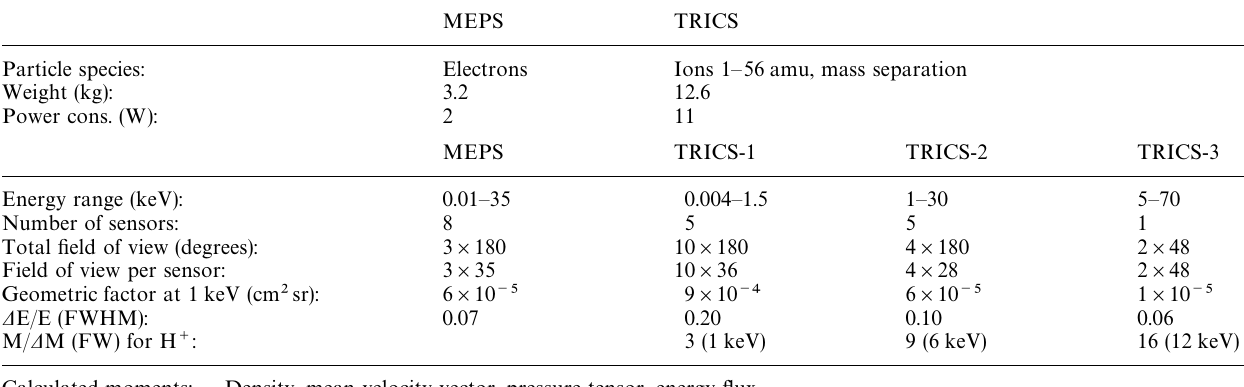
Table 1. Summary of instrument